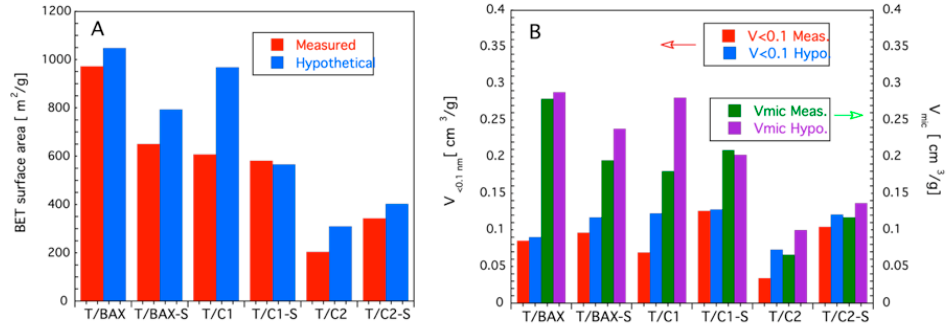
Figure 4. Comparison between the measured and hypothetical values: ( A ) surface area; ( B ) pore volumes of the hybrids.